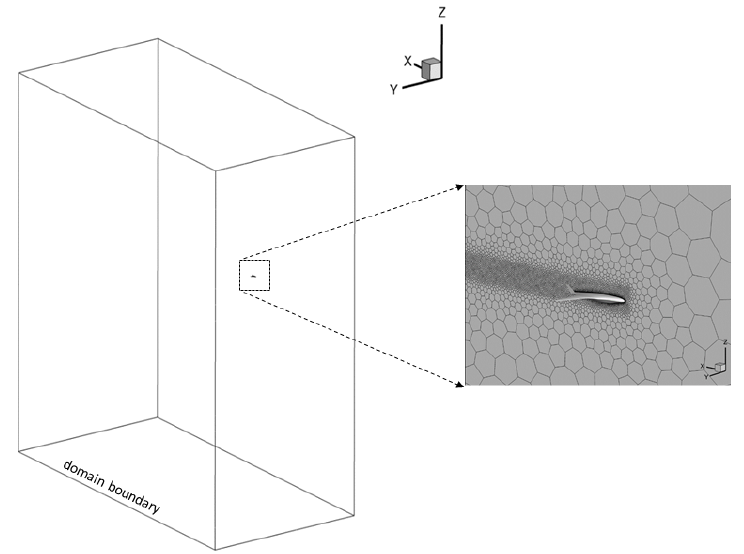
Figure 4. Computational domain brick with the details of the aircraft on its